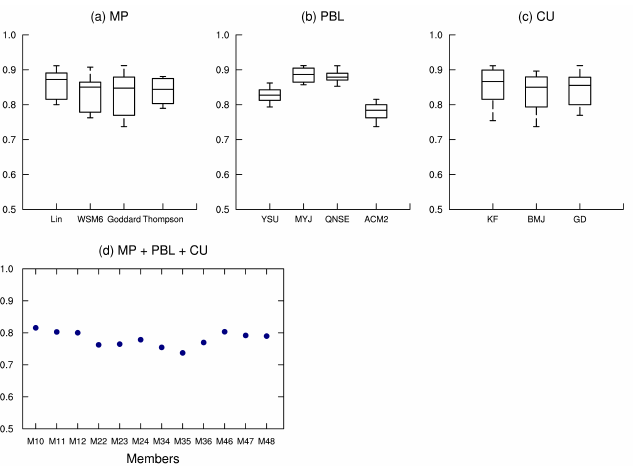
Figure 10. Box plots of the average metric split by physical parameterization of WRF model during 12:00–23:00 UTC. The second row retains only those members with YSU and ACM2 PBL